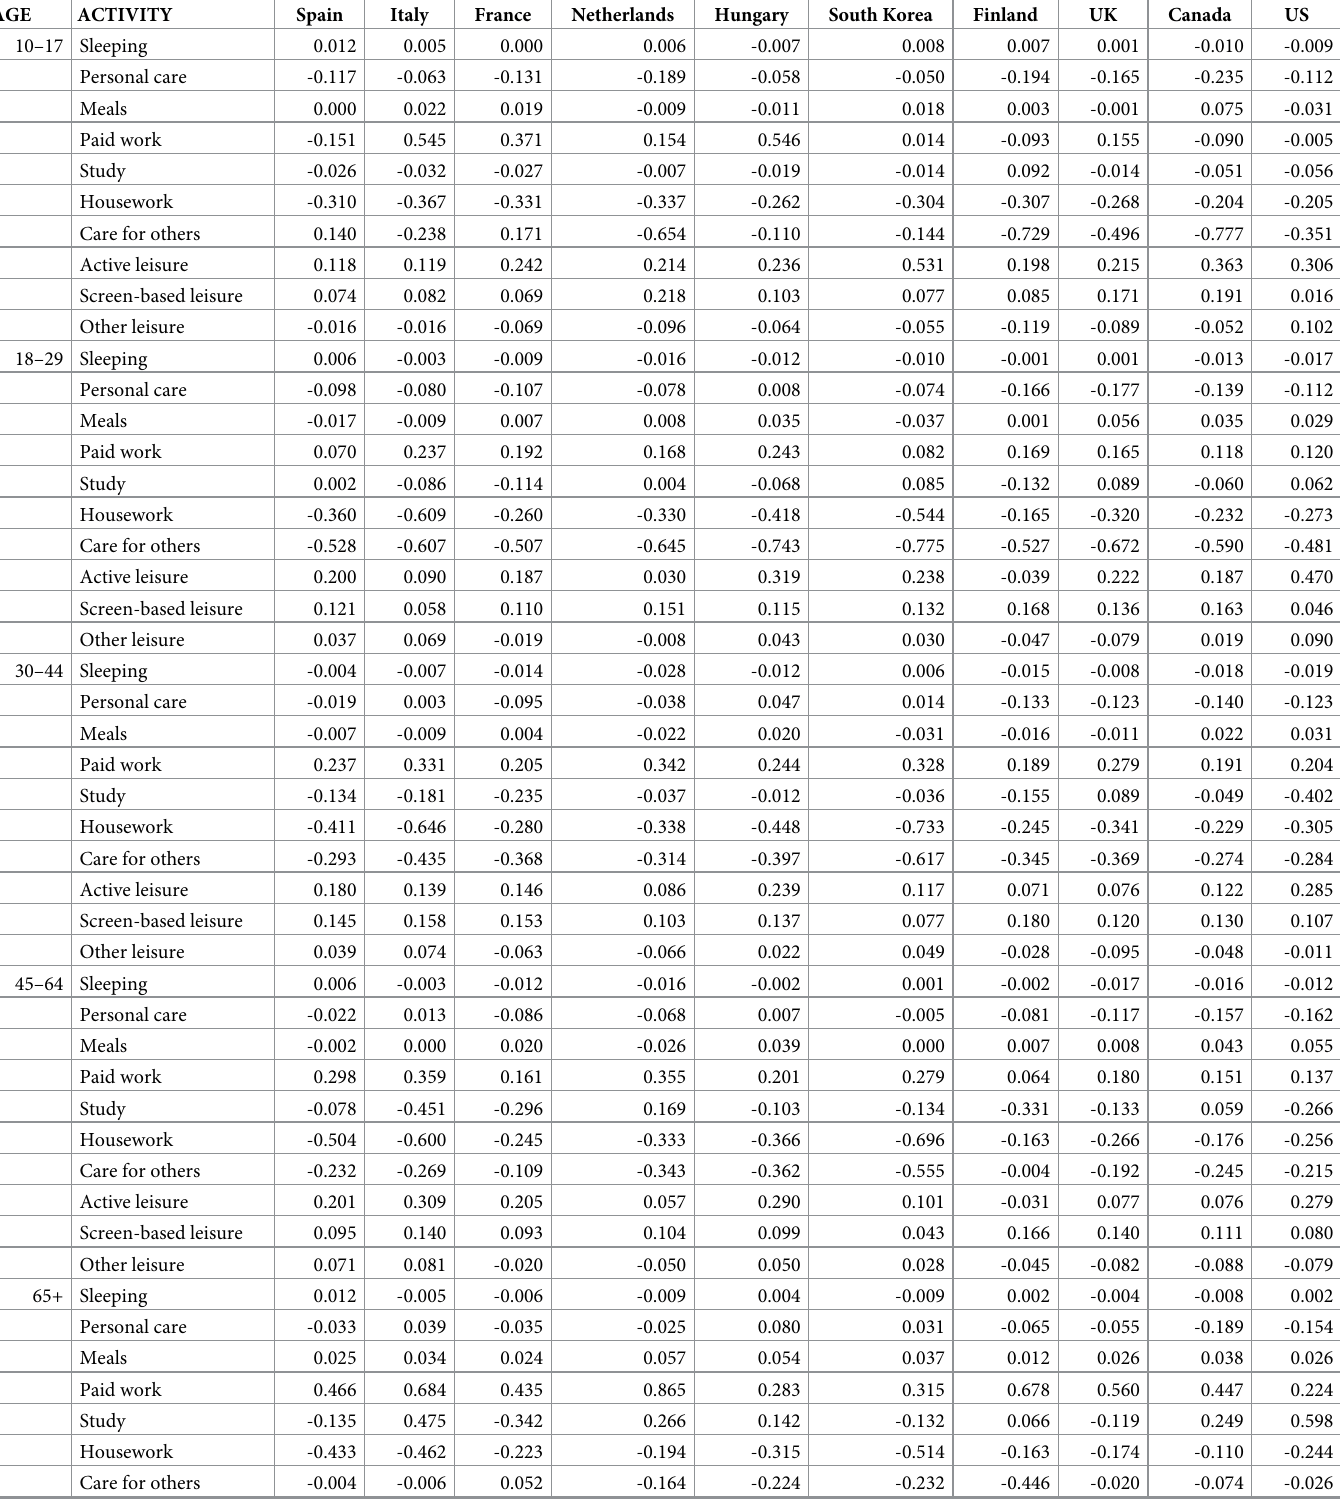
Table 4. Gender gaps in time use (Indicator from -1 to 1). Differences in activities by